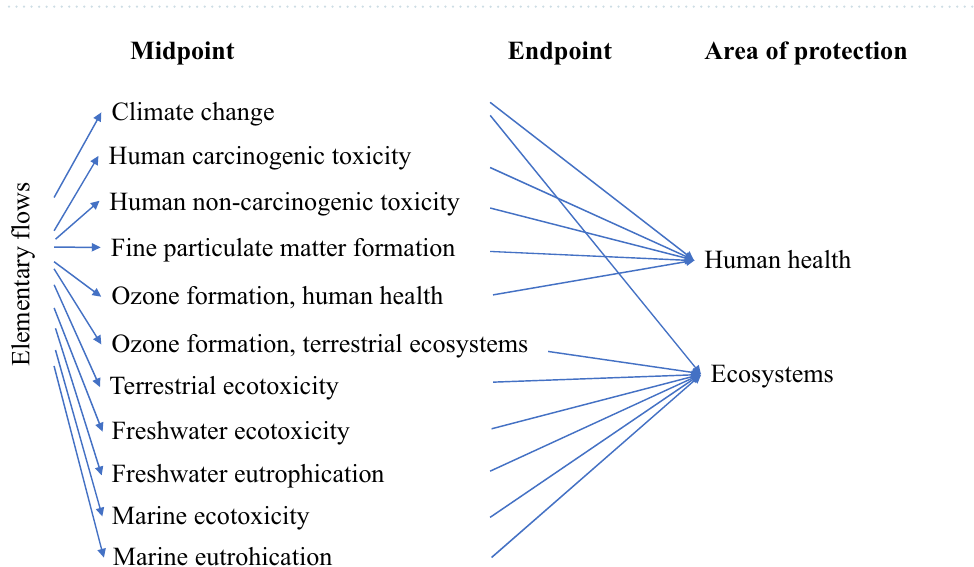
Figure 1. Map of the locations for the seven companies investigated in this study. The map was constructed with ArcGIS 10.6 software (https:// www. esri. com).